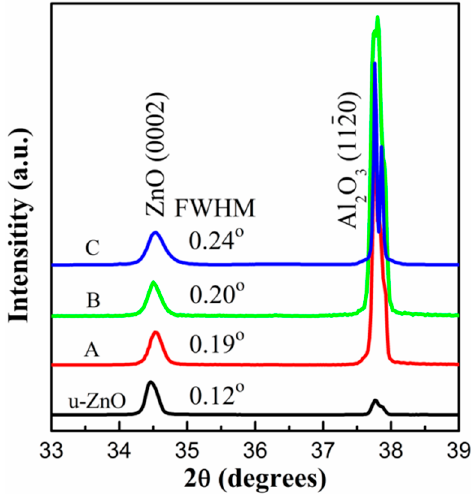
Figure 1. The XRD patterns of the undoped zinc oxide (ZnO), and ZnO:N films grown under (A) F NO = 0.8, F = 0.4, (B) F = 0.6, F = 0.6 and (C) F N2 NO N2